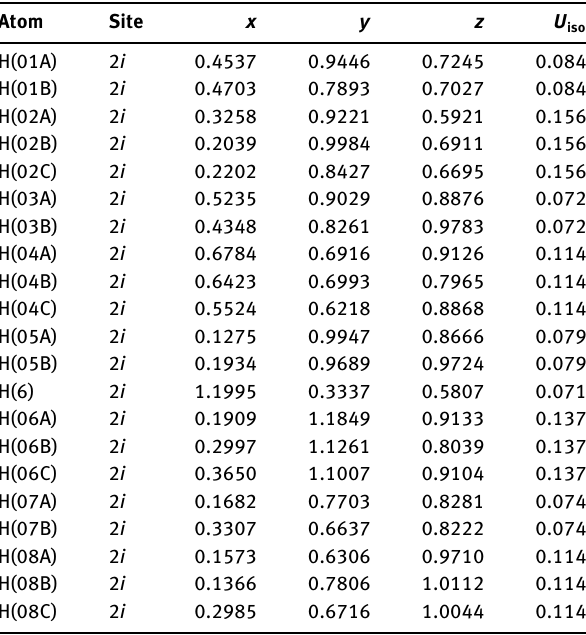
Table 2: Fractional atomic coordinates and isotropic or equivalent isotropic displacement parameters (Å 2 ).